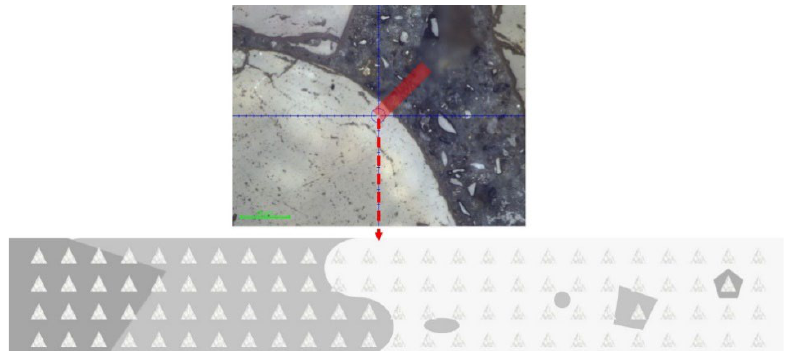
Figure 3. Schematic diagrams of the grid nanoindentation area.